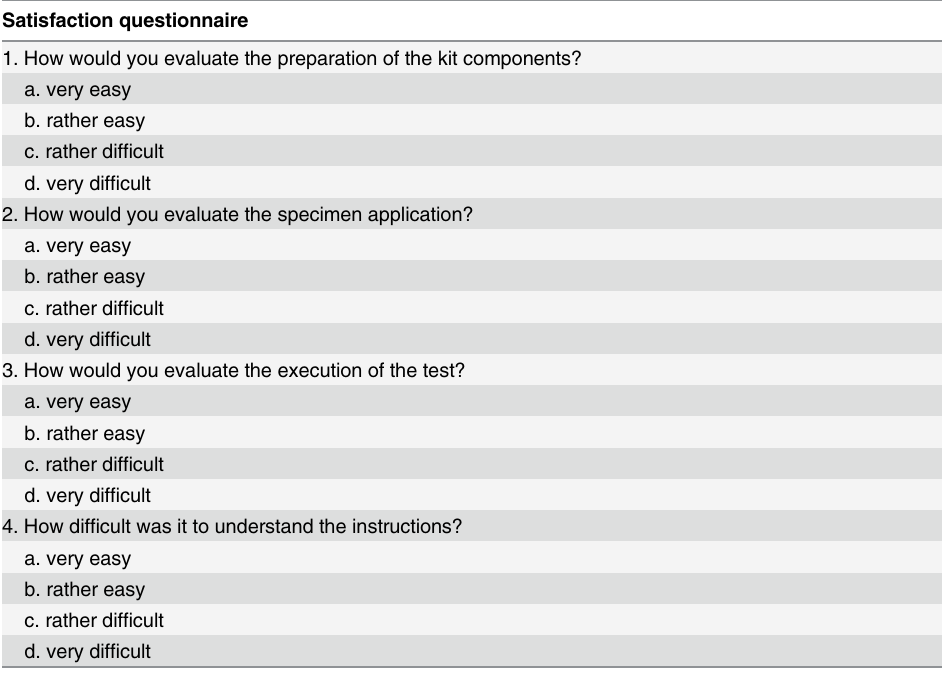
Table 2. Satisfaction